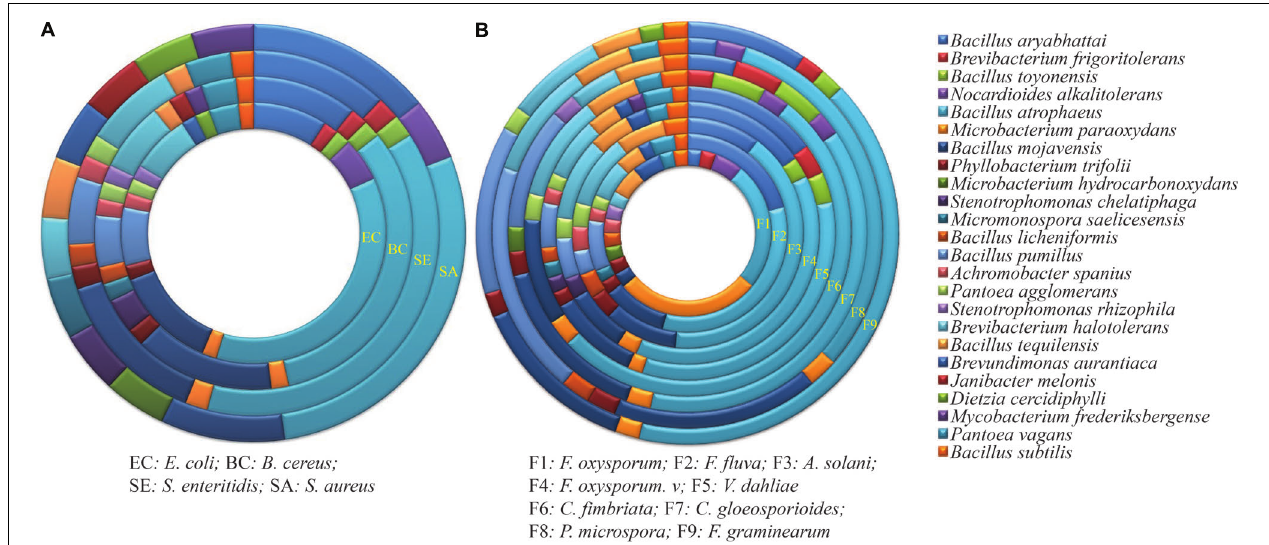
FIGURE 1 | Antimicrobial activity of endophytes against (A) four common bacteria and (B) nine fungal pathogens. Each ring represents the total number of strains with activity against the pathogen, and is divided into colors based on the proportion of each genus to that total. Details on the common bacteria and fungal pathogens are shown in Tables 1 , 2